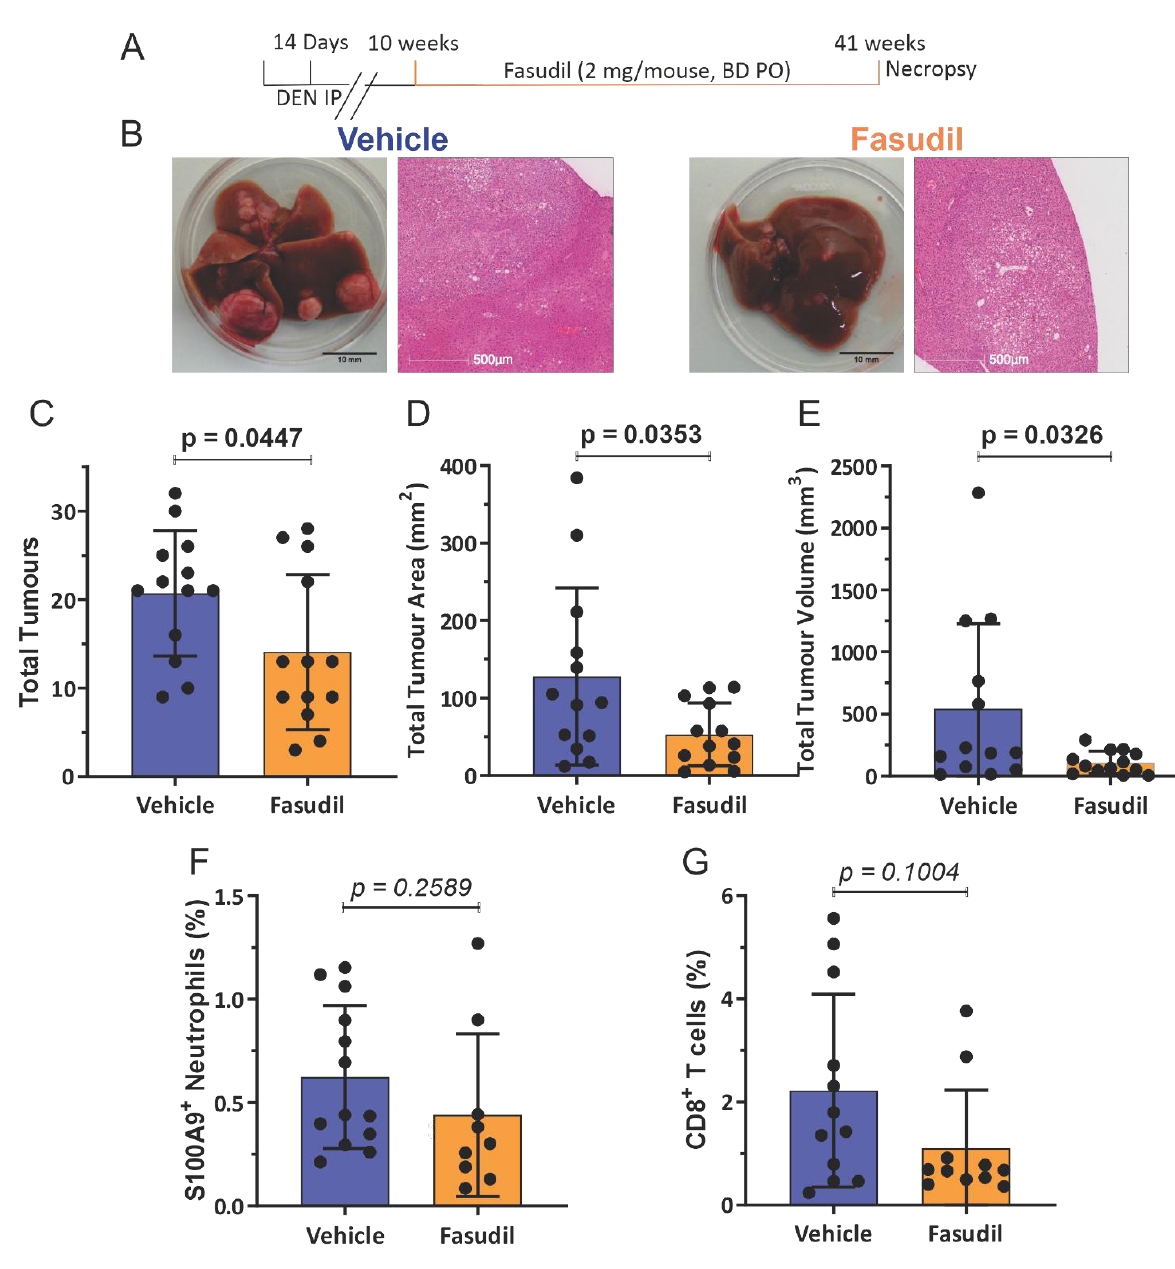
Figure 5. Fasudil-treated mice have fewer liver tumours but show no increase in immune cell recruitment. ( A ) Timeline of DEN + fasudil treatment regimen. ( B ) Macroscopic view of representative livers (scale bars = 10 mm) and representative H&E stained tumour sections (scale bars = 500 µm) from vehicle or fasudil treated mice. ( C ) Total tumour numbers in ROCK1wt mice treated with vehicle or fasudil. Means ± standard deviation, n = 13 mice per condition. ( D ) Total tumour areas in ROCK1wt mice treated with vehicle or fasudil. Means ± standard deviation, n = 13 mice per condition. ( E ) Total tumour volumes in ROCK1wt mice treated with vehicle or fasudil. Means ± standard deviation, n = 13 mice per condition. Liver cell suspensions were analyzed by flow cytometry to determine the relative proportions of ( F ) S100A9 positive neutrophils were scored as percentage of total cell counts per mouse. Means ± standard deviation, vehicle n = 13 mice, fasudil n = 9 mice, and ( G ). CD8 + T cells were scored as percentage of total cell counts per mouse. Means ± standard deviation, vehicle n = 12 mice, fasudil n = 11 mice. Unpaired Stude nt’s t -test, p values less than 0.05 indi- cated in bold typeface.